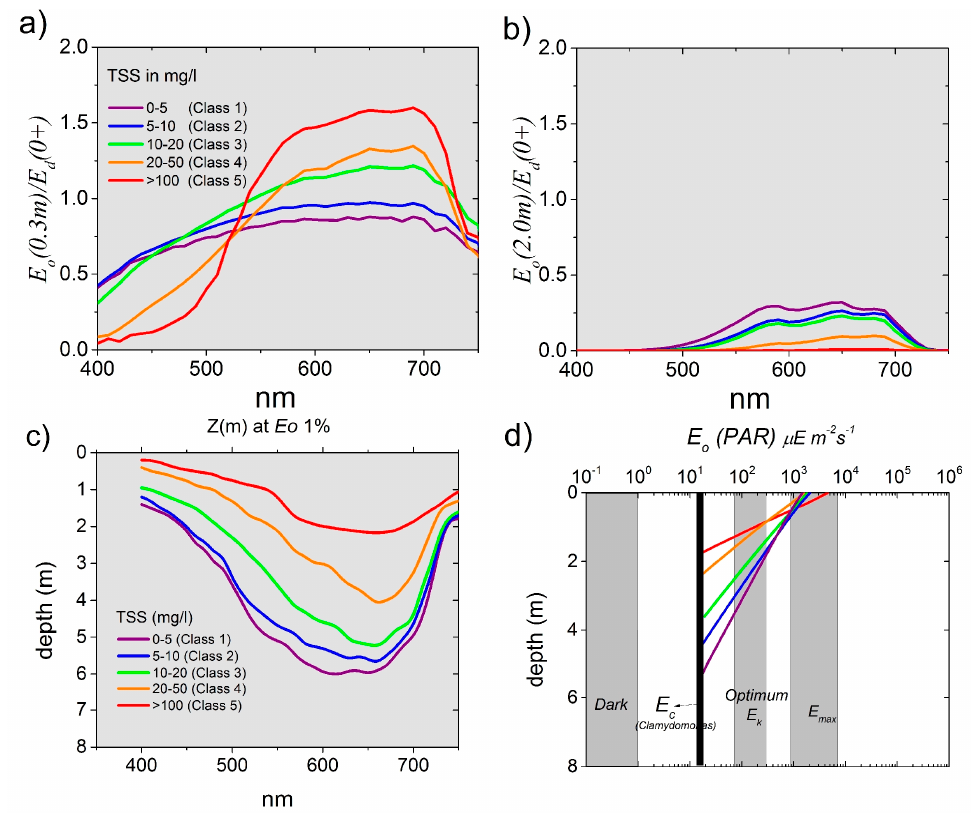
Figure 7. Normalized scalar irradiance at ( a ) 0.3 m and ( b ) 2.0 m for all samples grouped by TSS. ( c ) Spectral profile of Z 1% averaged for each class, and ( d ) E o (PAR) availability from surface to bottom with depth. Compensation irradiance E c (PAR) for Chlamydomonas sp. is indicated (thick vertical black line). The correspondent critical depth, Z c (PAR), for each class can be drawn from the intersection of E o (PAR) with the E c (PAR) line. E max , is the maximum level of irradiance that yields photosynthesis. Above this point, the incident light combined with upwelling light can be harmful for phytoplankton cells. The optimum irradiance level, E k , is between E c (critical) and E max .